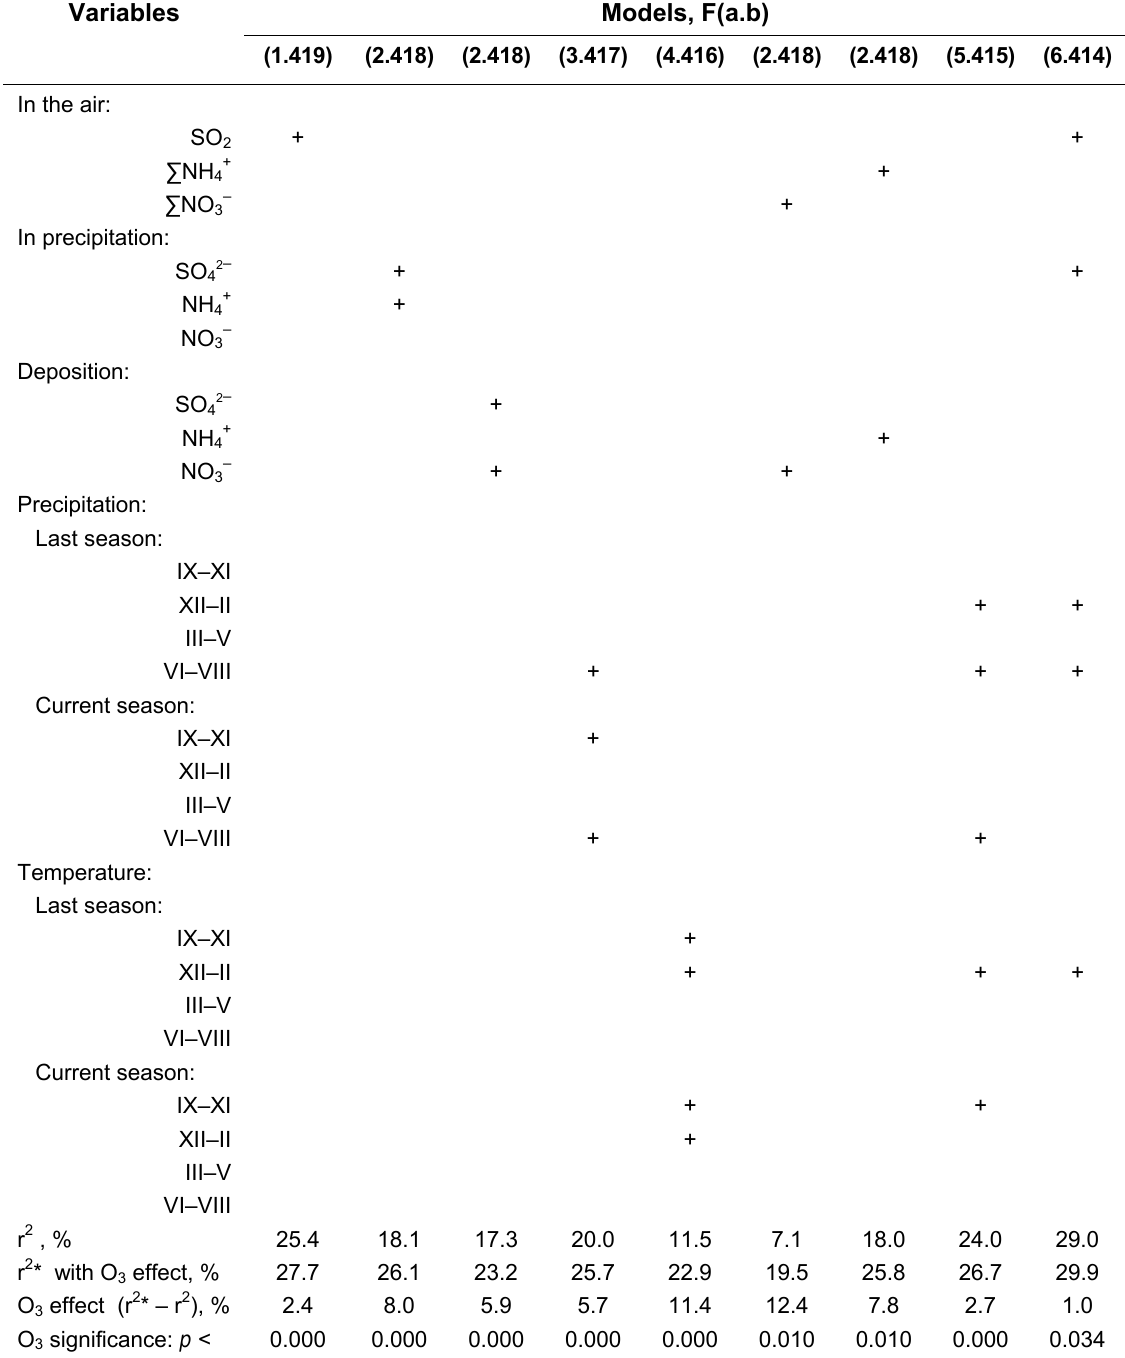
to Integrated Impact of Different Environmental Factors on Residuals Contribution of the O 3